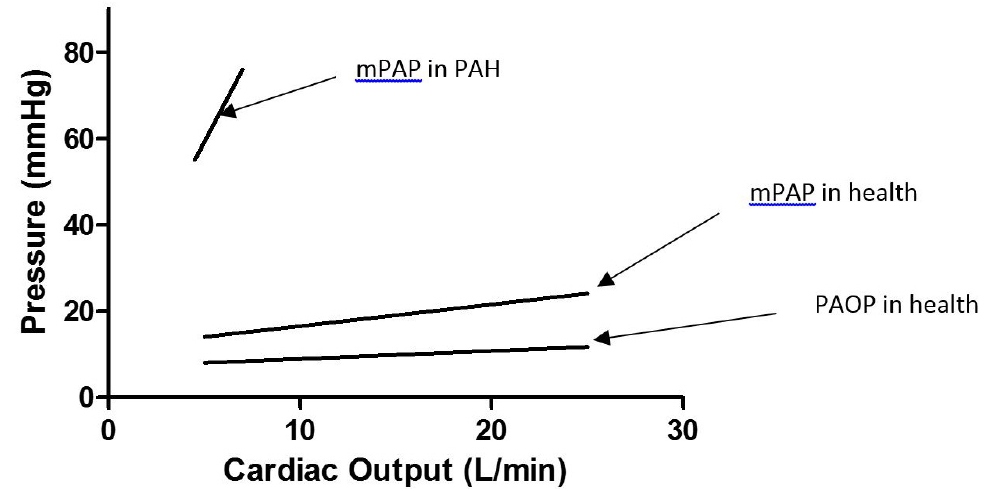
Figure 1. Mean data for healthy subjects taken from Kovacs et al. [22]. Mean data for subjects with pulmonary arterial hypertension (PAH) adapted from Provencher et al. [25]. Exercise performed in the supine position. mPAP: mean pulmonary artery pressure, PAOP: pulmonary artery occlusion